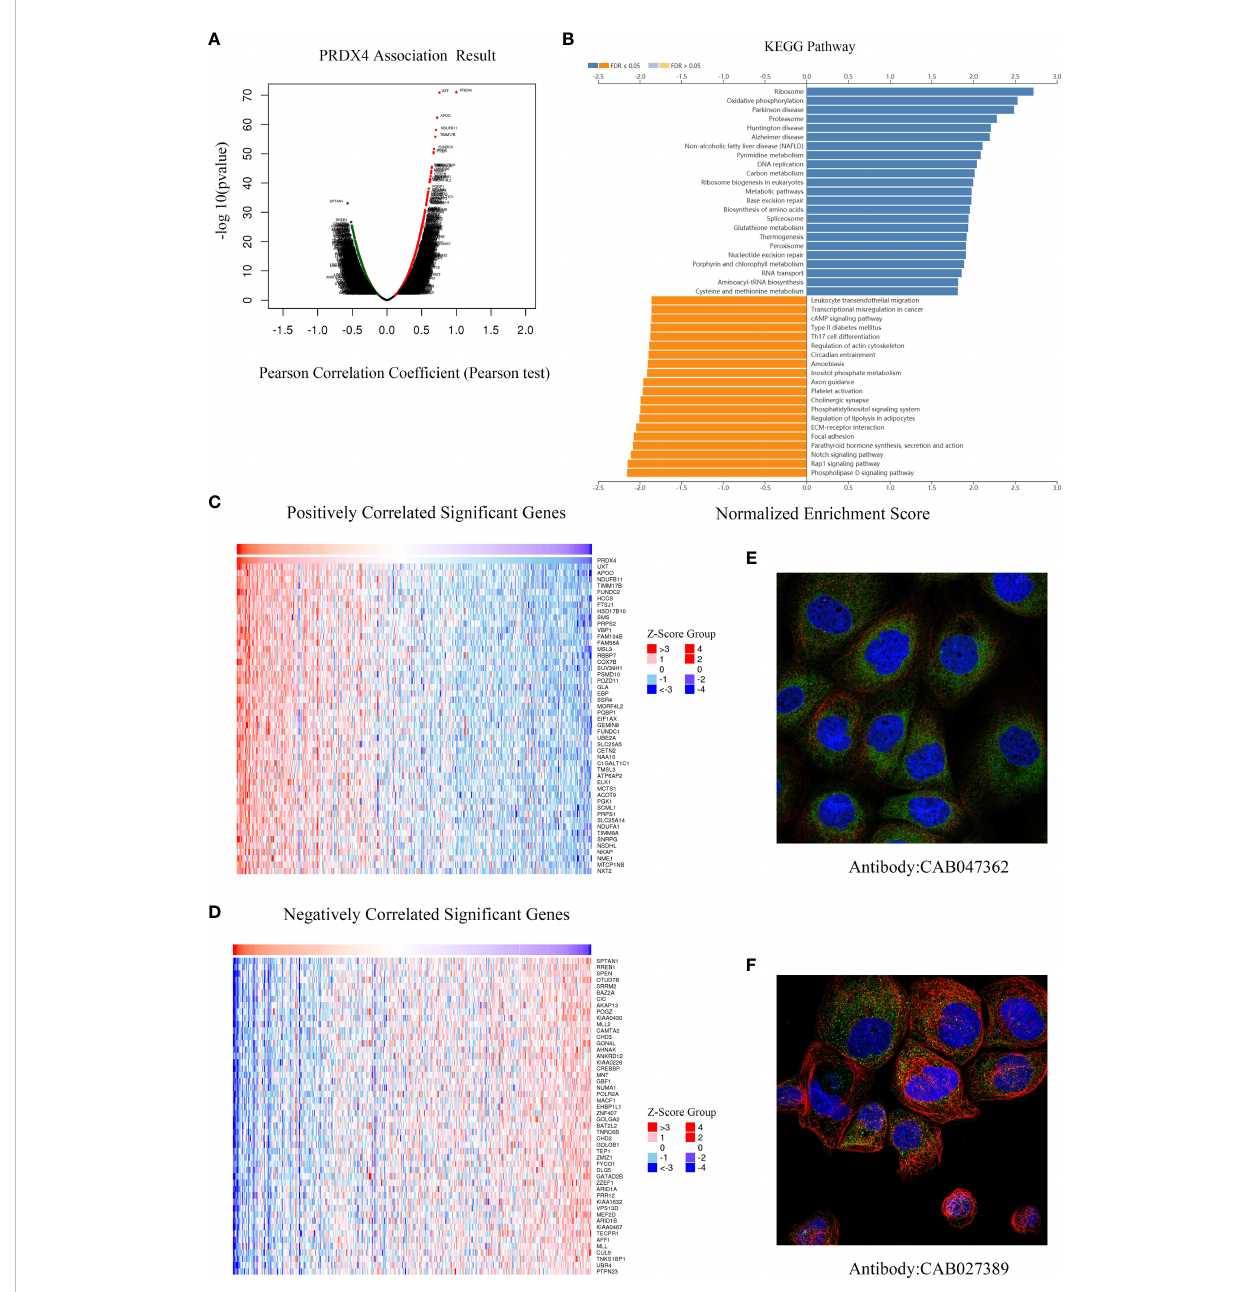
FIGURE 10 Differentially expressed genes associated with PRDX4 in CRC, KEGG pathway analysis and cellular localization (LinkedOmics). (A) Pearson test was used to analyze the correlation between PRDX4 and differentially expressed genes in CRC. (B) KEGG enrichment analysis showing functional pathways associated with PRDX4. (C, D) Heatmap analysis showing genes positively and negatively correlated with PRDX4 in CRC (Top 50). Red represents positively correlated genes, and green represents negatively correlated genes. (E, F) Subcellular localization of PRDX4. Green represents the target protein, blue represents the nucleus, and red represents the cellular microtubules. KEGG, kyoto encyclopedia of genes and